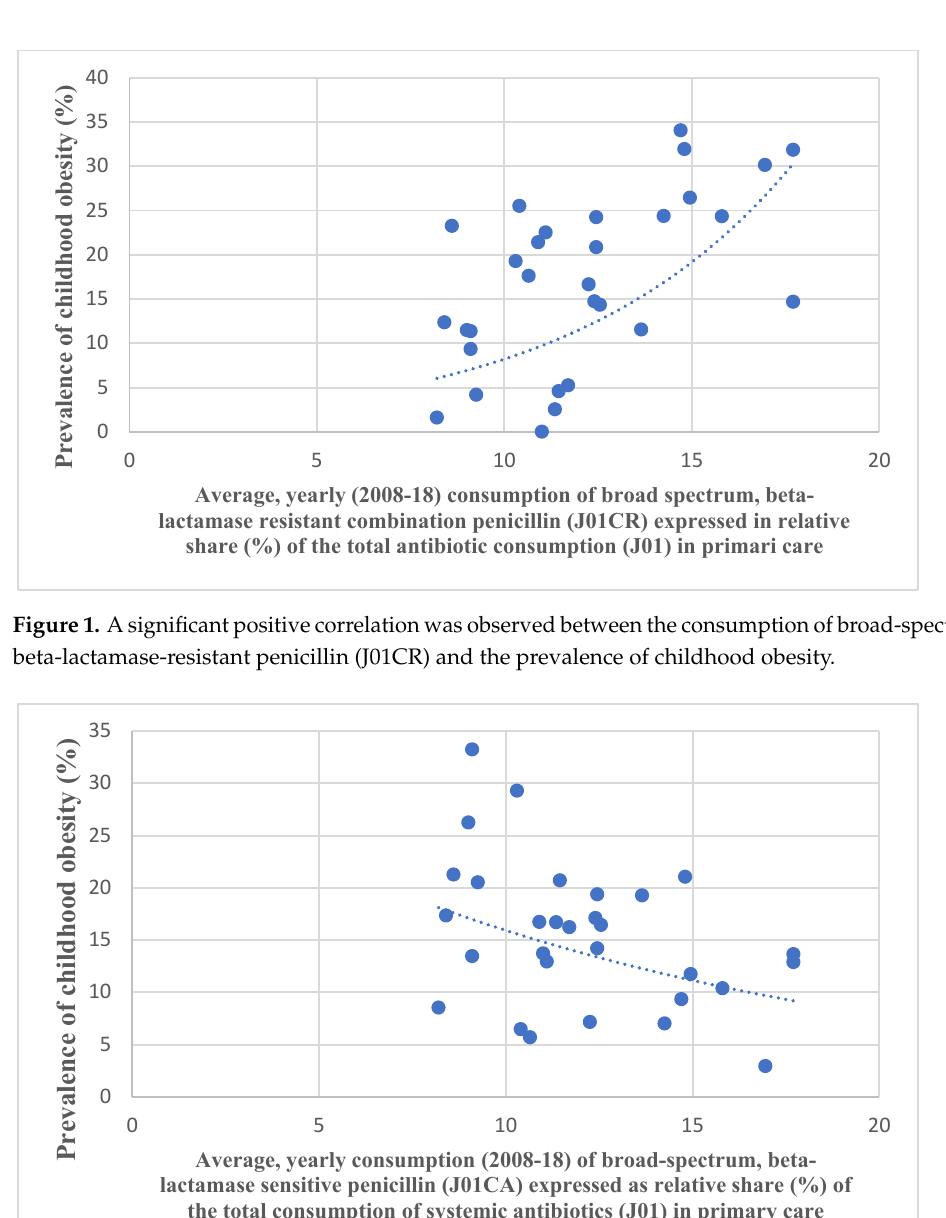
lactamase sensitive penicillin (J01CA) expressed as relative share (%) of the total consumption of systemic antibiotics (J01) in primary care Figure 2. A strong, negative correlation was observed between the consumption of broad ‐ spec ‐ trum, beta ‐ lactamase ‐ sensitive penicillin (J01CA) and the prevalence of childhood obesity.